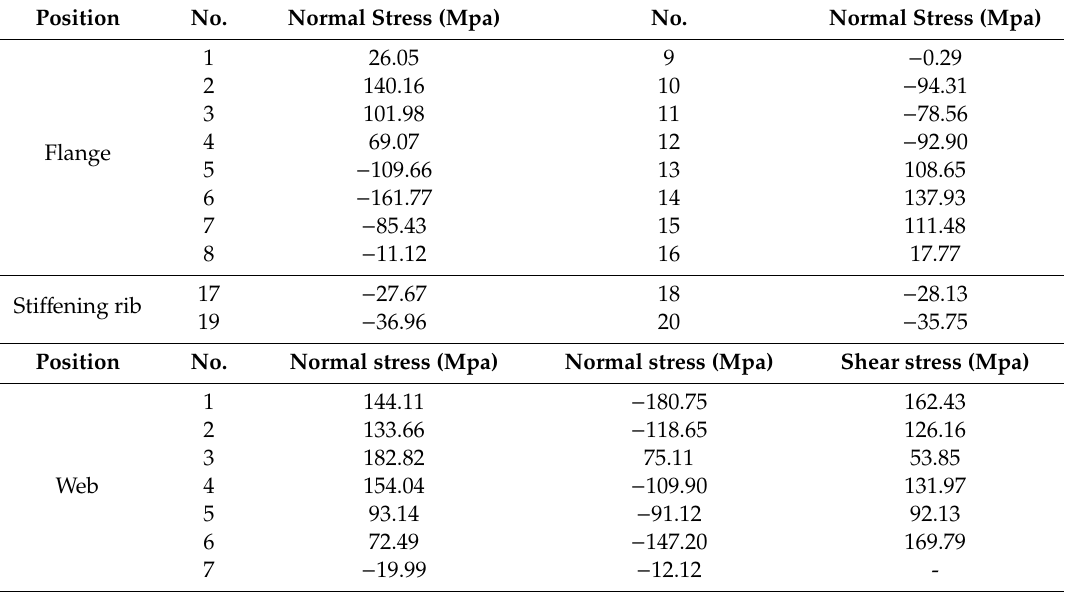
Table 4. The stress value of RSL-1 when D = − 18 mm (0.0847 rad).